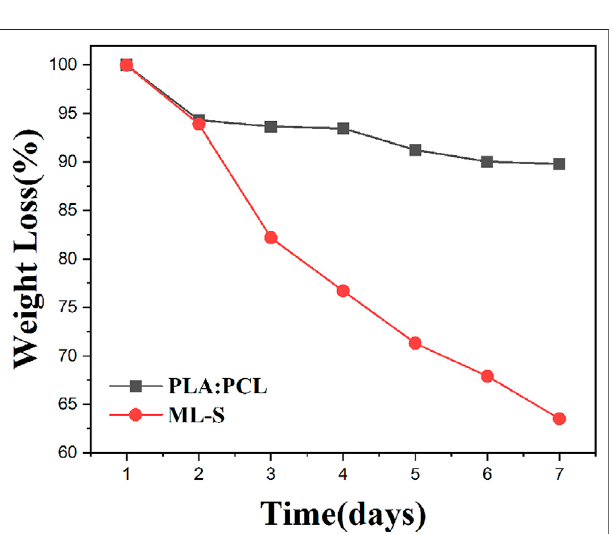
FIGURE 7 | Stress – strain curves of PLA:PCL, PVA, and ML-S.